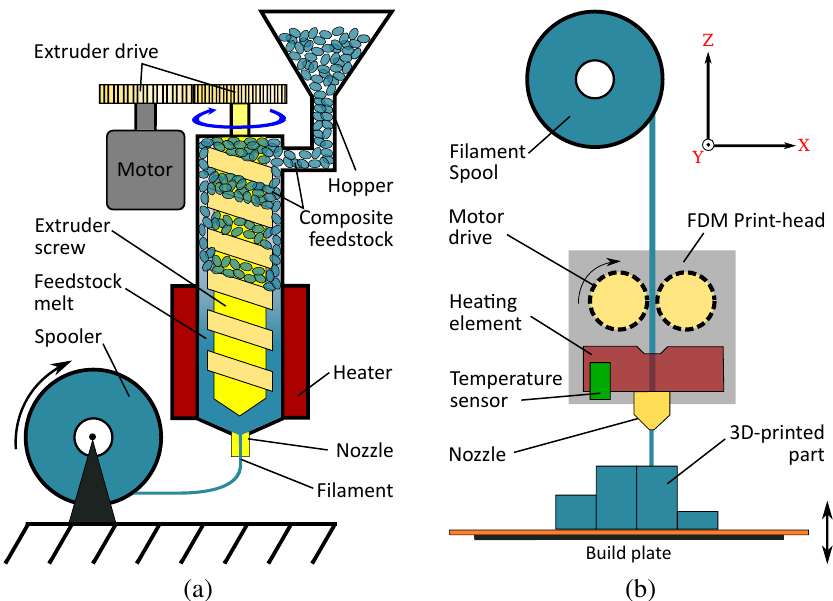
Figure 3. ( a ) A schematic depiction of the filament extrusion process. The kneaded composite material chunks are forced down a heated barrel using a screw, extruded through a nozzle of a defined diameter and spooled. ( b ) The FDM printing process: A motor drive forces the filament into the temperature-controlled print-head, mounted on an XY stage. After being forced through a nozzle, the material is deposited on to a build plate, which moves down to allow for the structuring of the next